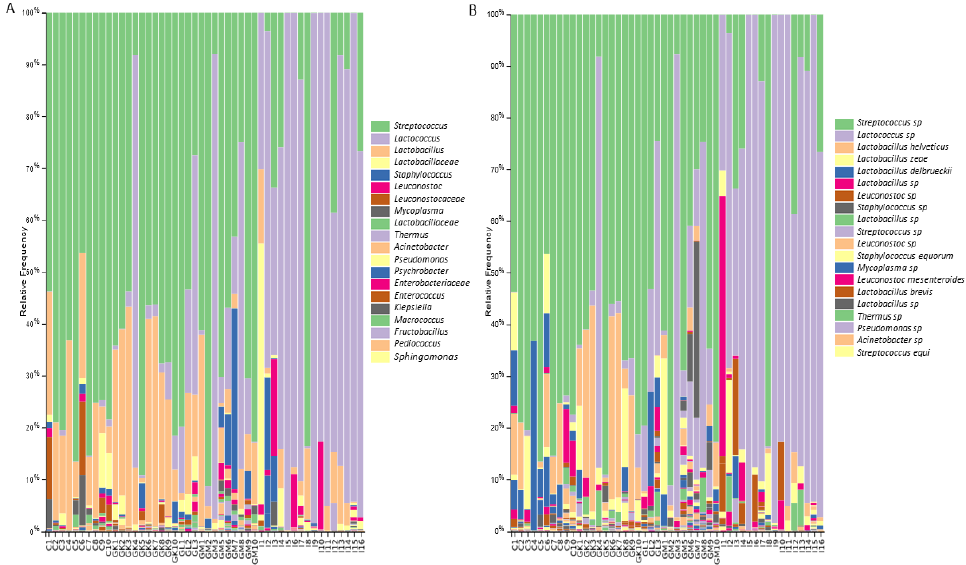
Figure 4. The relative abundance of the twenty most abundant bacteria identified at: ( A ) the genus level; ( B ) the species level, based on 16S rRNA gene sequencing for Cyprus, Greek, and Irish cheeses.